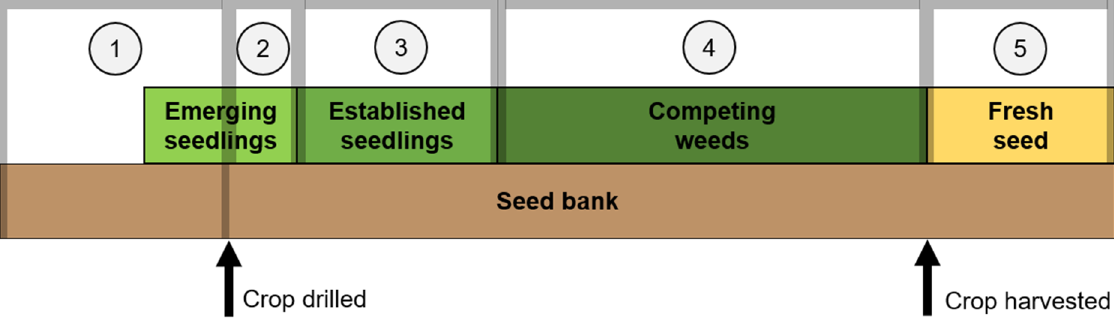
Figure 1. Illustration of five windows of opportunity for IWM options and the weed life stages impacted. These windows largely determine the classes of weed management options as they act on different life stages of the weeds. Tillage events are associated with Window 1, germination suppression events with Window 2, direct control events with Window 3 and competition events with Window 4. Recent advances in post-harvest weed control raise the possibility of an additional class associated with Window 5 that is not currently included in our framework.